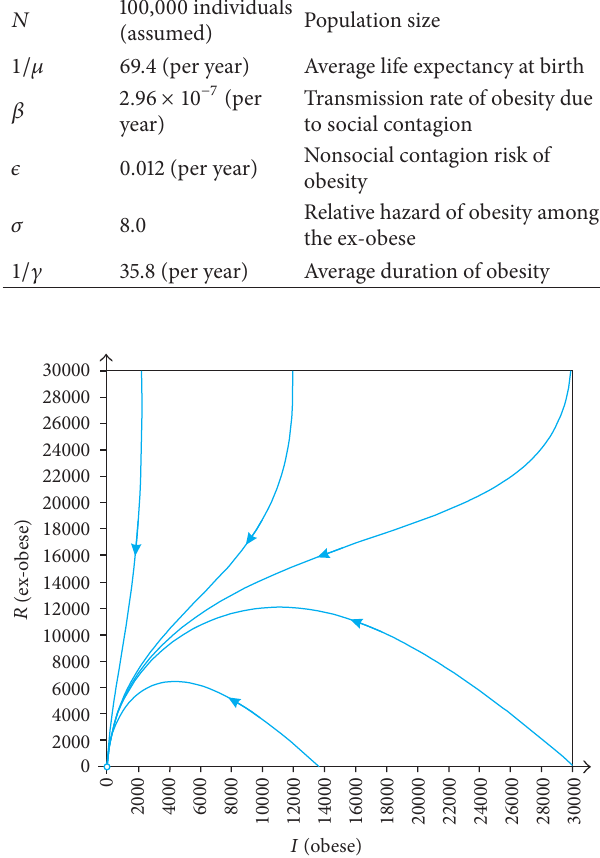
Figure 5: Phase portrait of system (6) (case 𝜖 = 0 ), for the value = 0.3 obtained by considering 𝛽 = 1.27 × 10 −7 𝑅 0